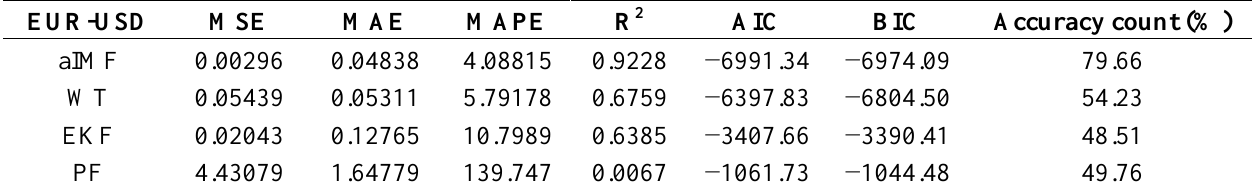
Table 2. Performance measurements of original datasets using noise distribution at 100% with 1 Hz and 20% amplitude of the original signals.